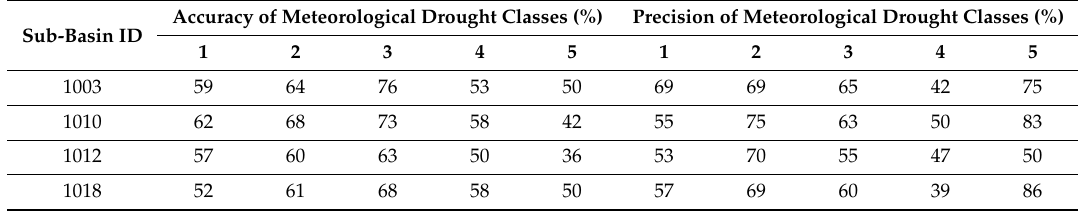
Table 3. Accuracy and precision of the MBC in the classification of meteorological drought classes.